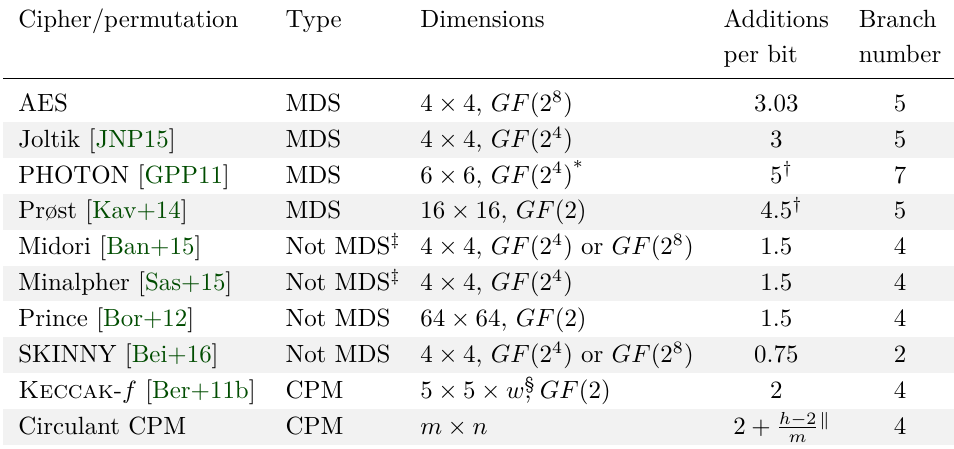
Table 1: Comparison of mixing